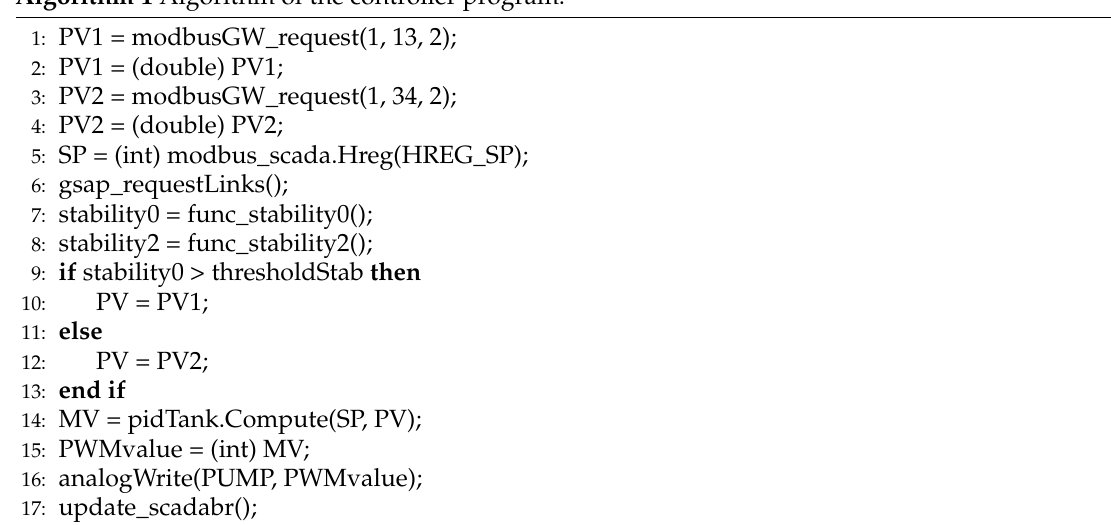
Algorithm 1 Algorithm of the controller